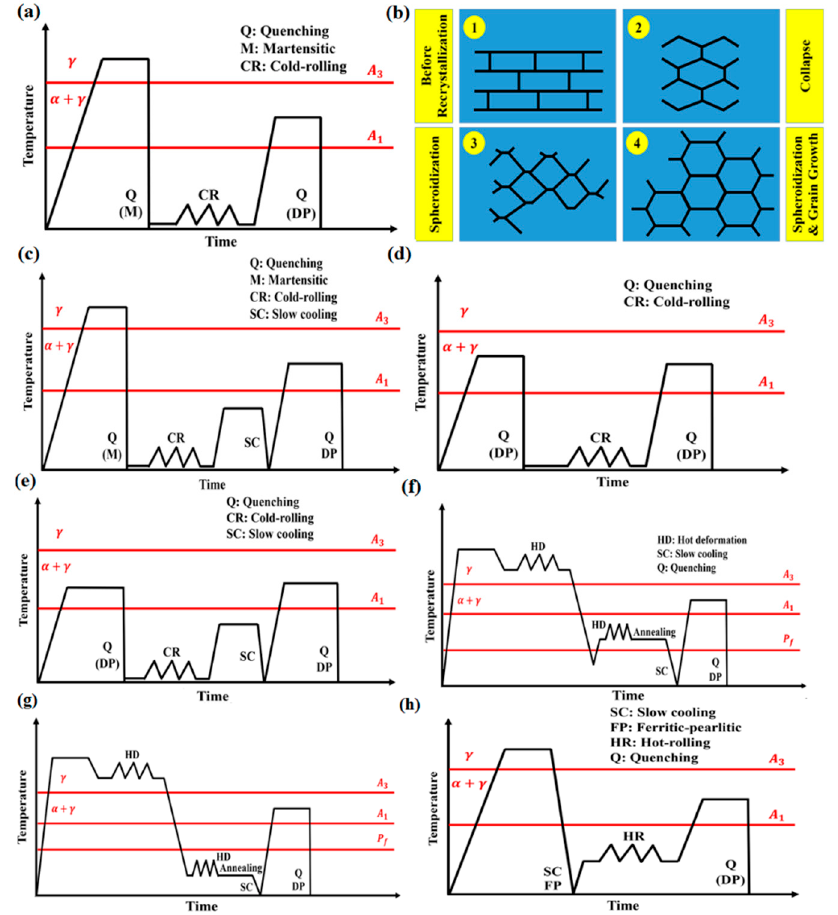
Figure 5. ( a ) The heat treatment regime (processing route 2) for FGS reduction. ( b ) Mechanism of continuous recrystallization: (1) before recrystallization, (2) collapse, (3) spheroidization, and (4)